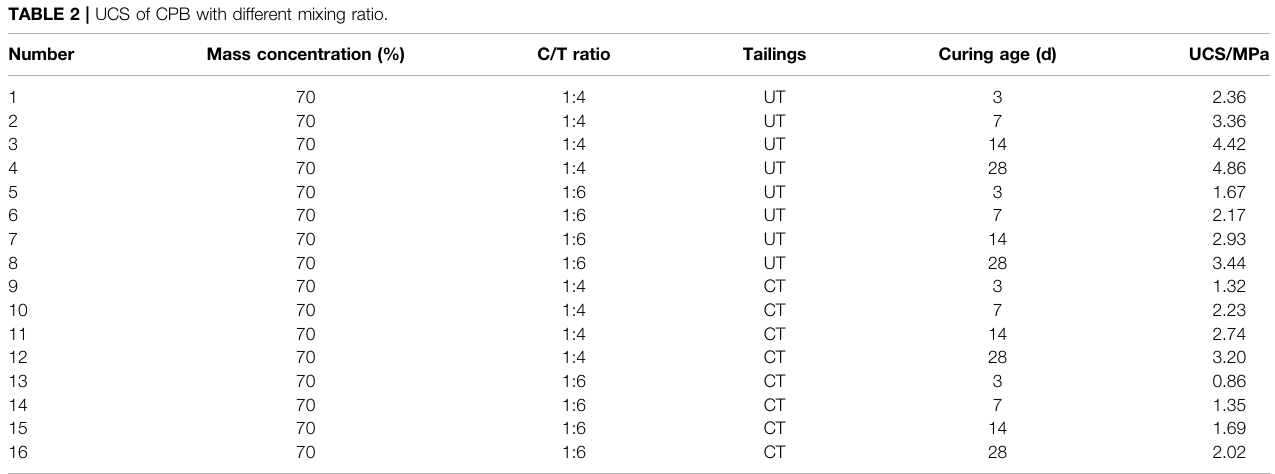
TABLE 2 | UCS of CPB with different mixing ratio. Number Mass concentration